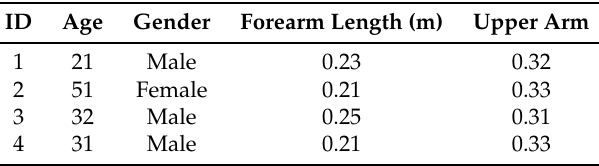
Table 2. Main subject data from the validation experiment.